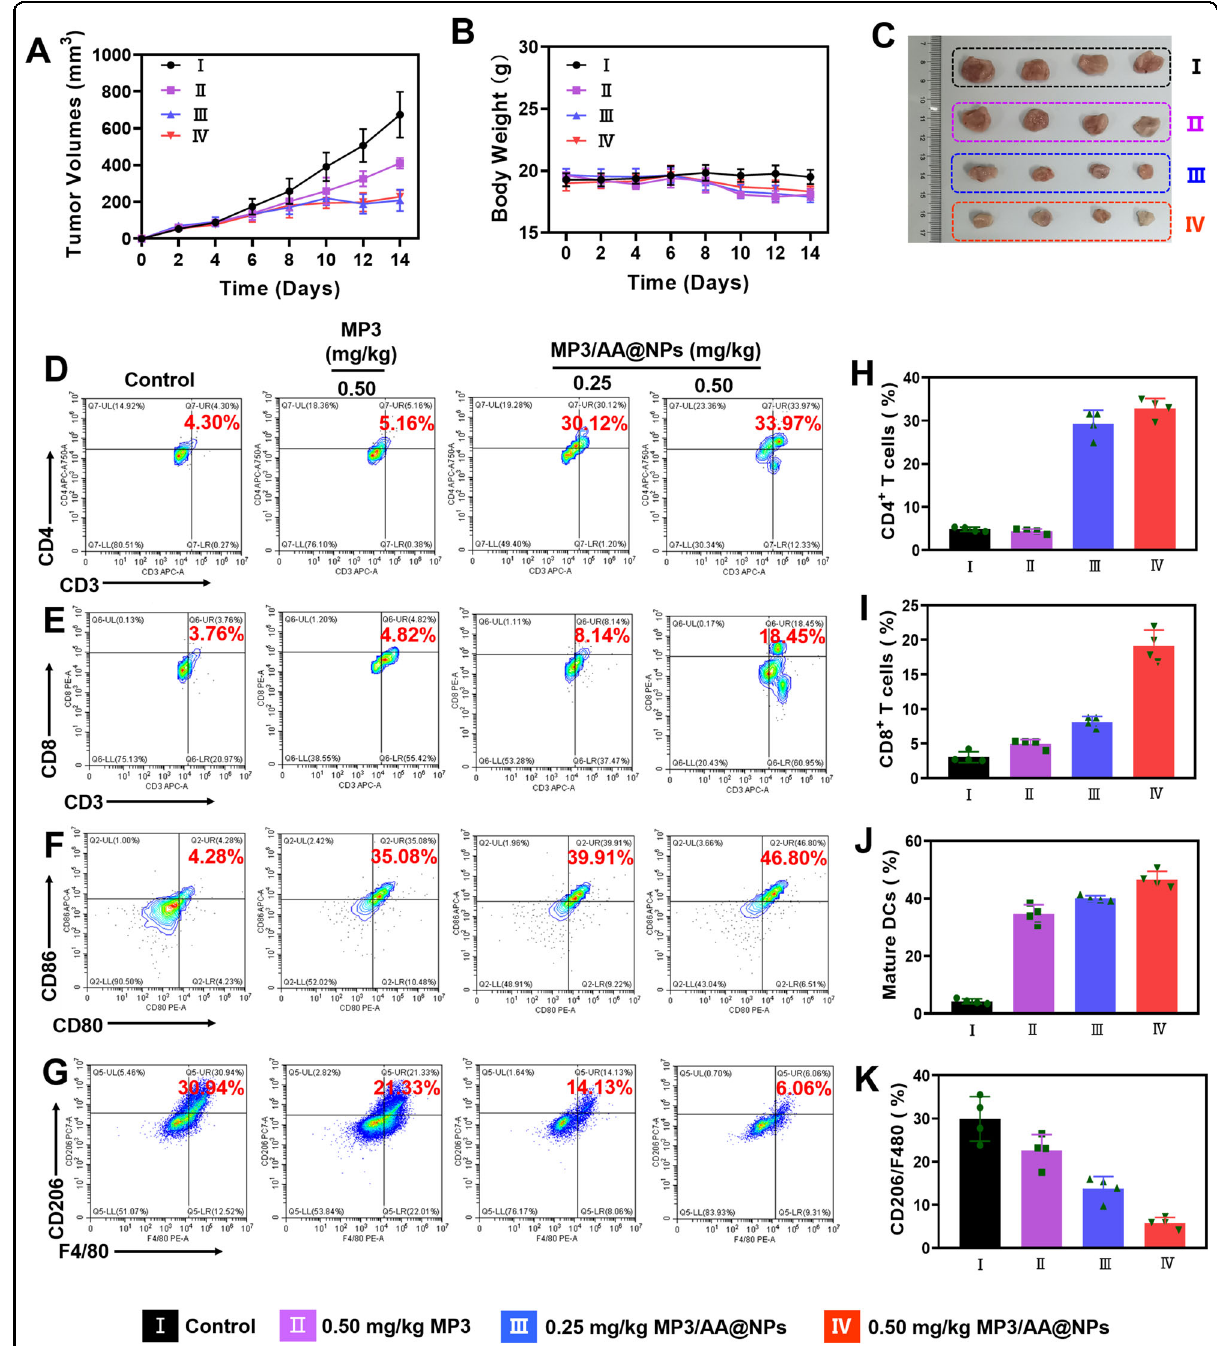
Fig. 7 Anticancer immunity of MP3 and MP3/AA@NPs in 4T1 tumor-bearing mice. A Tumor volumes, B body weights change, C representative tumor tissues collected after 14 days treatment of different groups. The ratio of ( D ) cytotoxic T lymphocytes (CD3 + CD8 + T cells), E T helper (Th) cells (CD3 + CD4 + T cells), G M2 macrophages (F4/80 + CD206 + ) in tumors, and F the maturation status of DCs (CD80 + CD86 + ) in lymph nodes, as detected by fl ow cytometric. The quanti fi cation of intratumoral in fi ltration of T lymphocytes, H CD4 + T cells and I CD8 + T cells, K the number of M2 macrophages and J maturation DCs in lymph